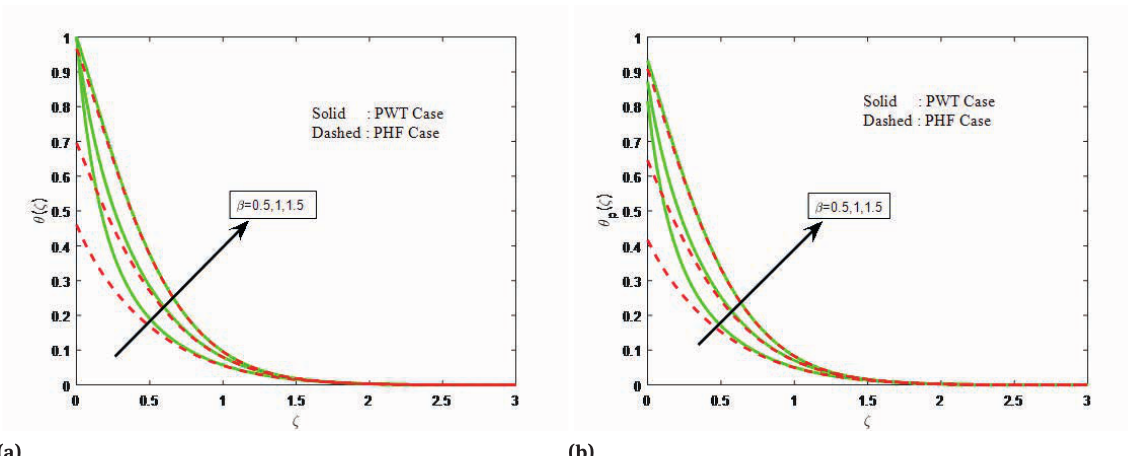
Fig. 5: a,b) Temperature profiles with varying fluid particle interaction parameter ( β